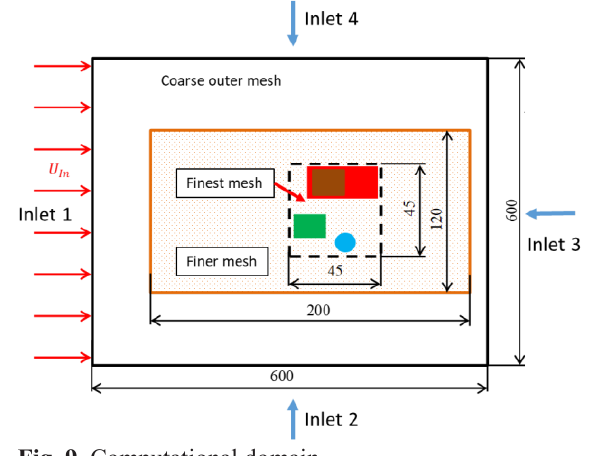
Fig. 9. Computational